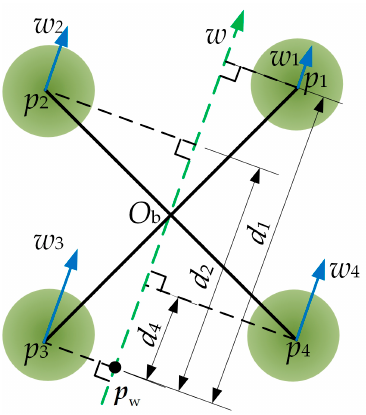
Figure 9. Chart of calculating the wind speed around each propeller.